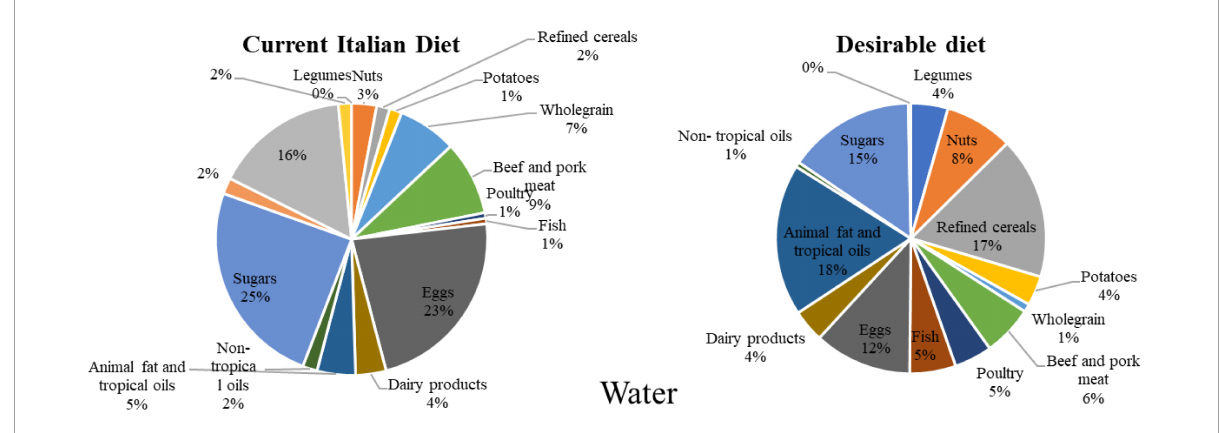
FIGURE3 Water footprint associated with the weekly consumption of foods in the desirable and the current Italian diet (Source: Authors).